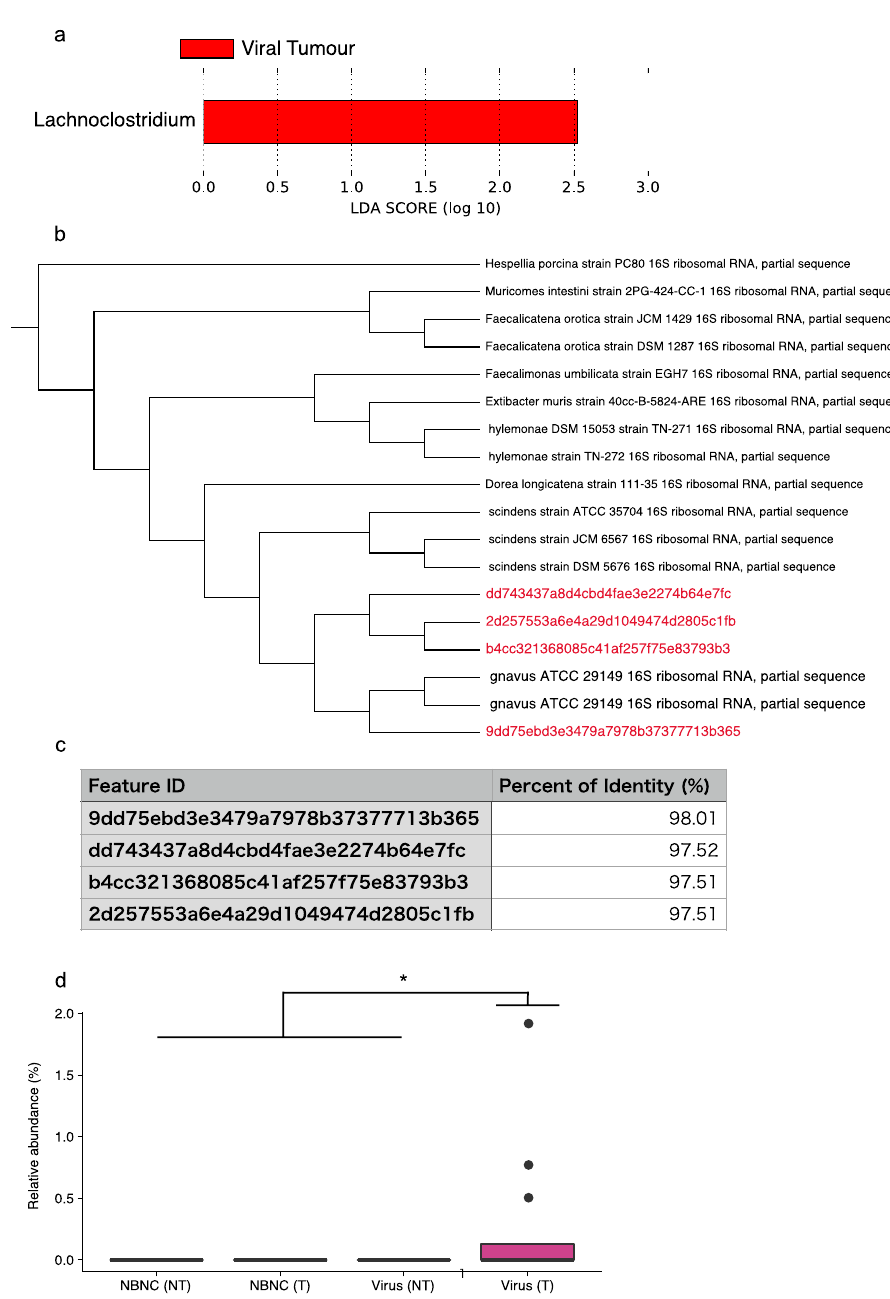
Figure 4. R. gnavus is a marker taxon for viral HCC. ( a ) Discriminating taxa between the non-tumour and tumour regions both of viral and NBNC HCC determined by LefSe analysis 15 . ( b , c ) Related species of feature sequences assigned as Lachnoclostridium genus. Phylogenetic tree based on 16S rRNA gene sequences shows species homologous to the feature sequences ( b ), and the table displays sequence identity of the feature sequences to R. gnavus 16S rRNA gene sequence ( c ). ( d ) Relative abundance of R. gnavus in the non-tumour (NT) and tumour (T) regions both of viral and NBNC HCC. Each boxplot represents median, interquartile range (IQR), the lowest and highest values within 1.5 IQRs of the first and third quartiles, and the outliers shown with dots. Significant differences are indicated at the top of the panels (* p < 0.05; the Kruskal–Wallis test followed by the pairwise t test with Benjamini–Hochberg method). [NBNC (NT): n = 18; NBNC (T): n = 23; viral (NT): n = 15; viral (T): n =